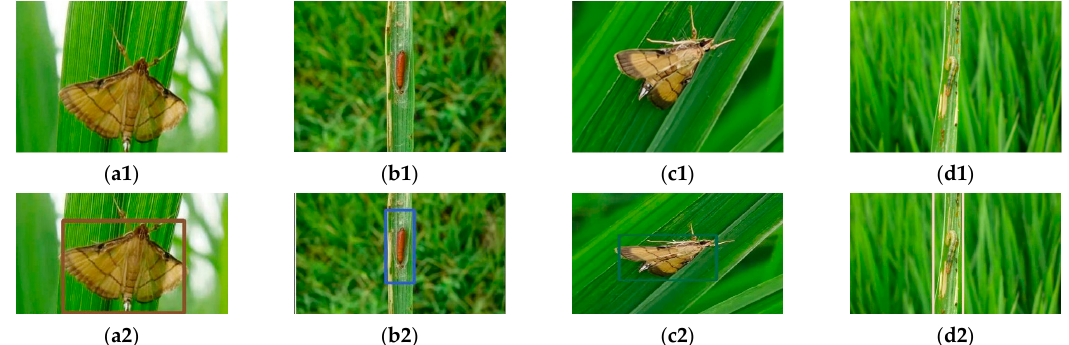
Figure 6. Rice-leaf roller. ( a1 ), ( b1 ), ( c1 ), and ( d1 ) are the original images; ( a2 ), ( b2 ), ( c2 ), and ( d2 ) are the recognition results. the recognition results.